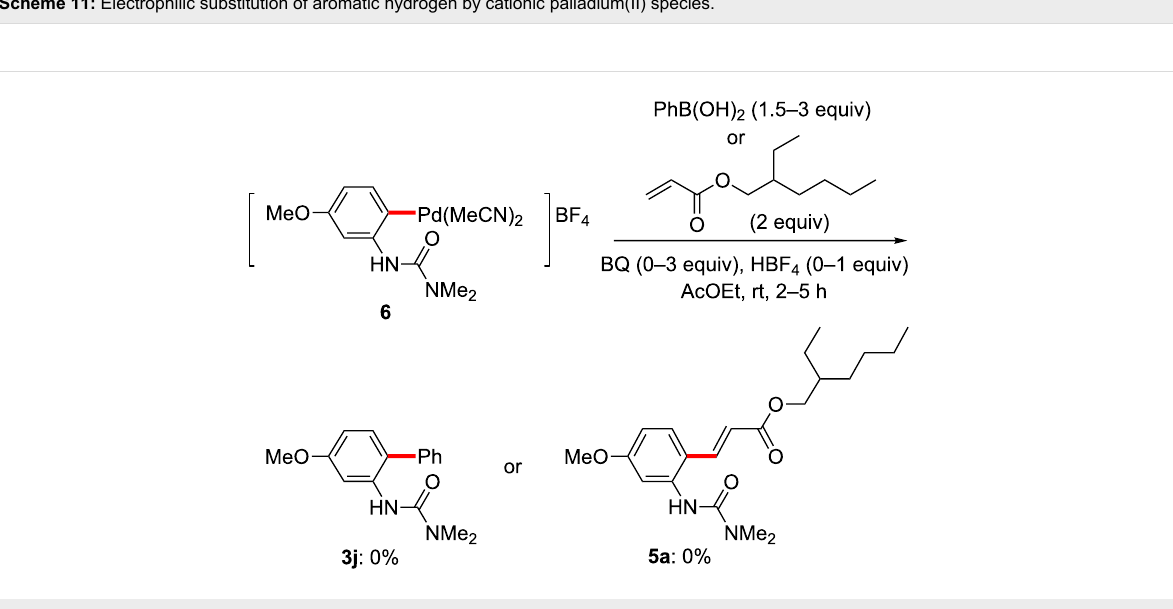
Scheme 12: Attempted reactions of palladacycle 6